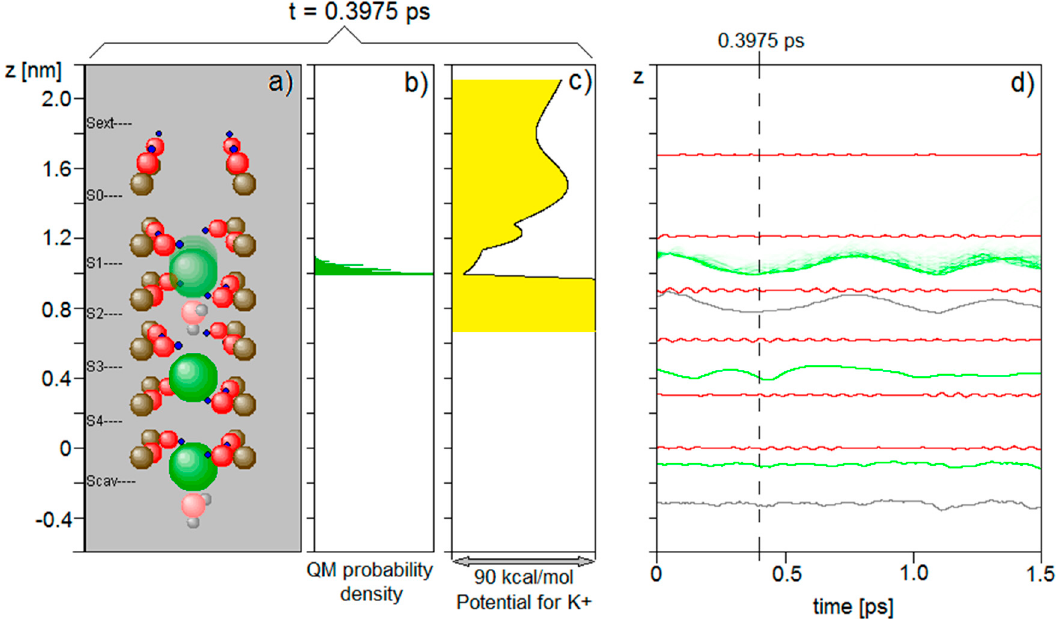
Figure A1. Snap shot of a quantum wave evolution at t = 0.3975 ps after initiation of the topmost K + ion as a Gaussian quantum mechanical wave packet ( a , b , c ) and z-coordinates of all particles as a function of time ( d ). ( a ) Configuration of the selective filter. The topmost K + ion is spread out; ( b ) quantum mechanical probability density along the z -axis of the mass center of the topmost K + ion at this instant of time; ( c ) potential to which the quantum mechanical wave packet is exposed at this moment of time. The yellow region is the range covered by the calculation. It extends beyond the region with appreciable probability to avoid artificial cut off effects. The K + ion wave packet is strongly confined to the lowest potential valley and is propagating back and forth within this region. In order for a significant escape it has to extend over the hill at z = 1.5 nm; ( d ) z-coordinates of the moving particles as a function of time. Green: K + ions, where the wave packet of the topmost ion is shown in shades corresponding to the probability density of location (darkest shade = highest probability density). Grey: water molecules. Red: oxygen atoms of the carbonyl groups. The dashed line indicates positions which are shown in the panels a , b , c .